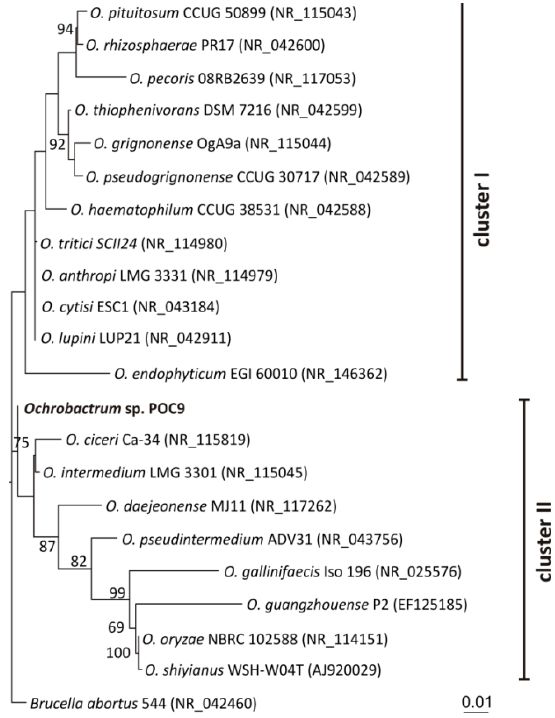
Figure 1. Phylogenetic tree for 16S rDNA sequences of Ochrobactrum spp. The tree was